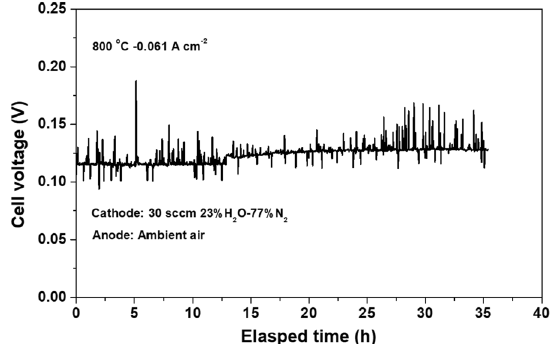
Fig. 5 The electrochemical performance durability results recorded at 800 °C and a constant electrolysis current density of − 0.061 A/cm 2 with 23%H 2 O–77%N 2 as the fuel and ambient air as the oxidant